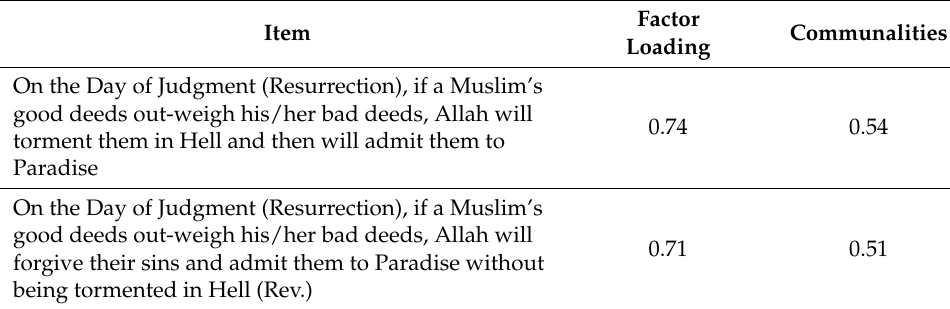
Table 1. Factor loadings and communalities from principal component analysis for Compulsory Temporary Afterlife Punishment Belief Scale (CTAPB) ( n =